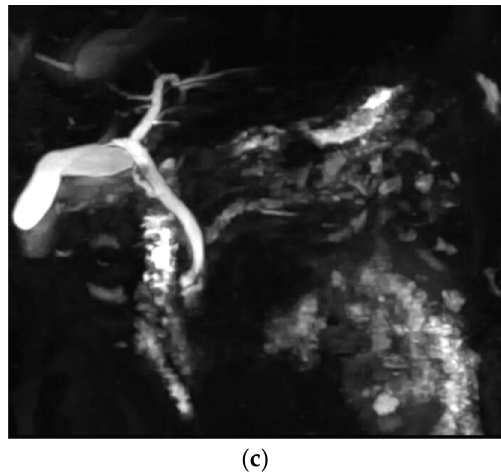
Figure 4. A 57-year-old male with chronic pancreatitis. A 2D thick-slab MRCP ( a ), as a reference standard, clearly depicts dilated pancreatic duct with multiple filling defects, compatible with chronic pancreatitis. Overall image quality was comparable between conventional MRCP ( b ) (score 3) and optimized BH-CS-MRCP ( c ) (score 3). However, image degradation by artifacts (3 vs. 4.5) and background suppression (3 vs. 3.5) was better with optimized BH-CS-MRCP. The pancreatic duct is well depicted on optimized BH-CS-MRCP, while it is hardly recognized on conventional MRCP. In addition, the visibility of CBD and IHD was all better with optimized BH-CS-MRCP, except for the Rt 2nd level IHD (4 vs. 1).